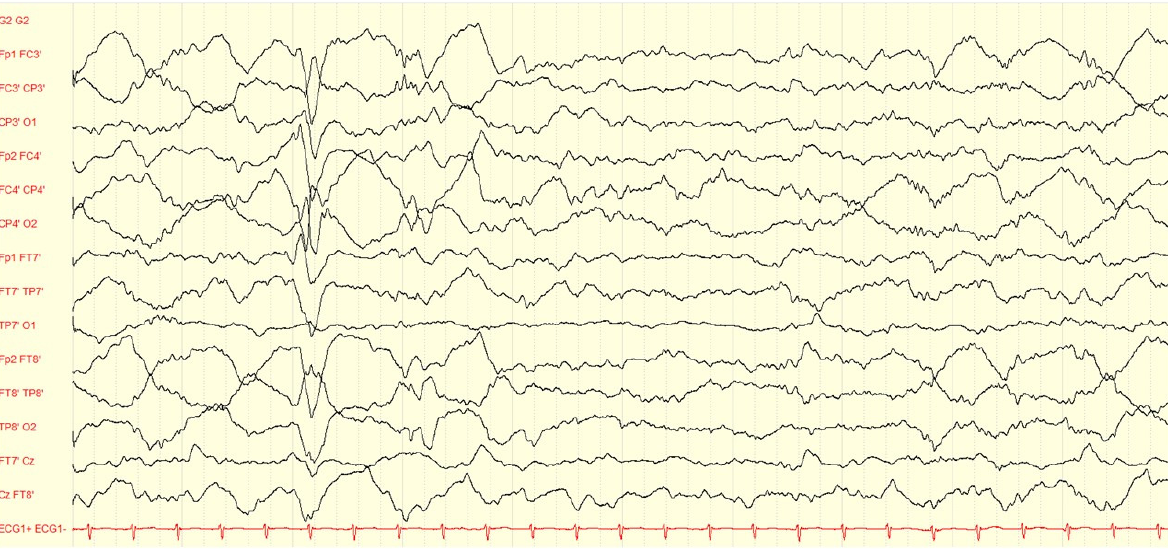
Figure 3. Continuous EEG trace of the same neonate of Figure 2 at age one week. Seizure freedom and EEG improvement after initiating pyridoxine treatment correlated with neurological improvement (less lethargic, needs less O2, better feeding). Highpass: 0.530 Hz, Lowpass: 70